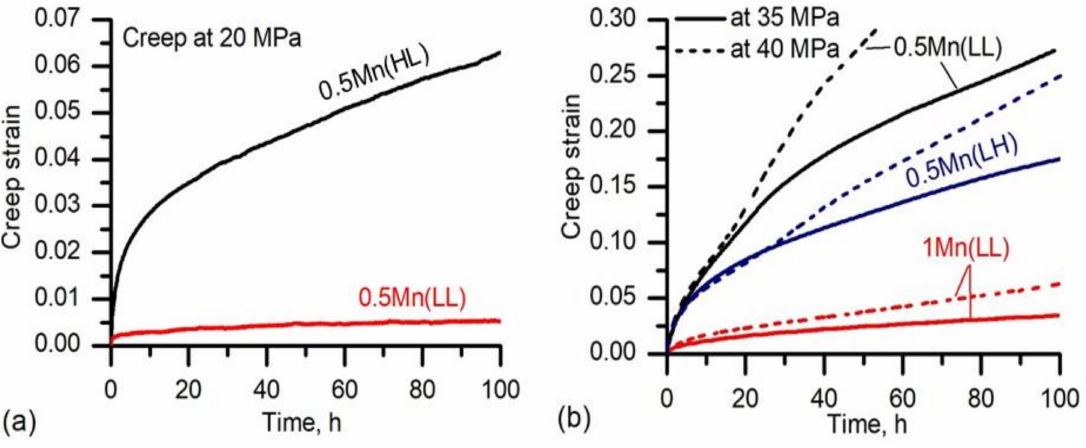
Figure 8. Typical creep curves from tests performed at 300 ◦ C under the applied stress of ( a ) 20 MPa, ( b ) 35 MPa, and 40